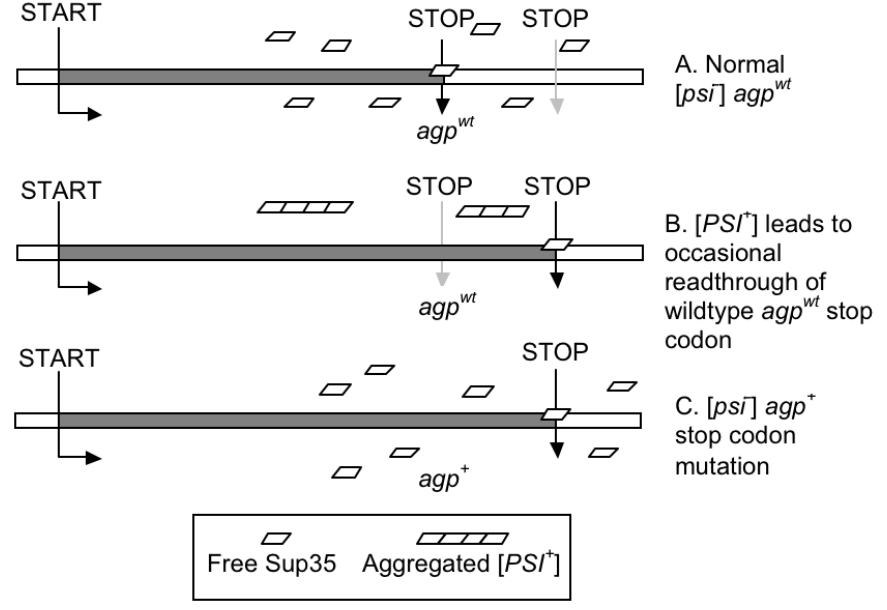
Figure 1. Different mechanisms of readthrough translation. Either the presence of [ PSI + ] (B) or an agp + point mutation (C) can lead to readthrough of the wild-type stop codon (A).